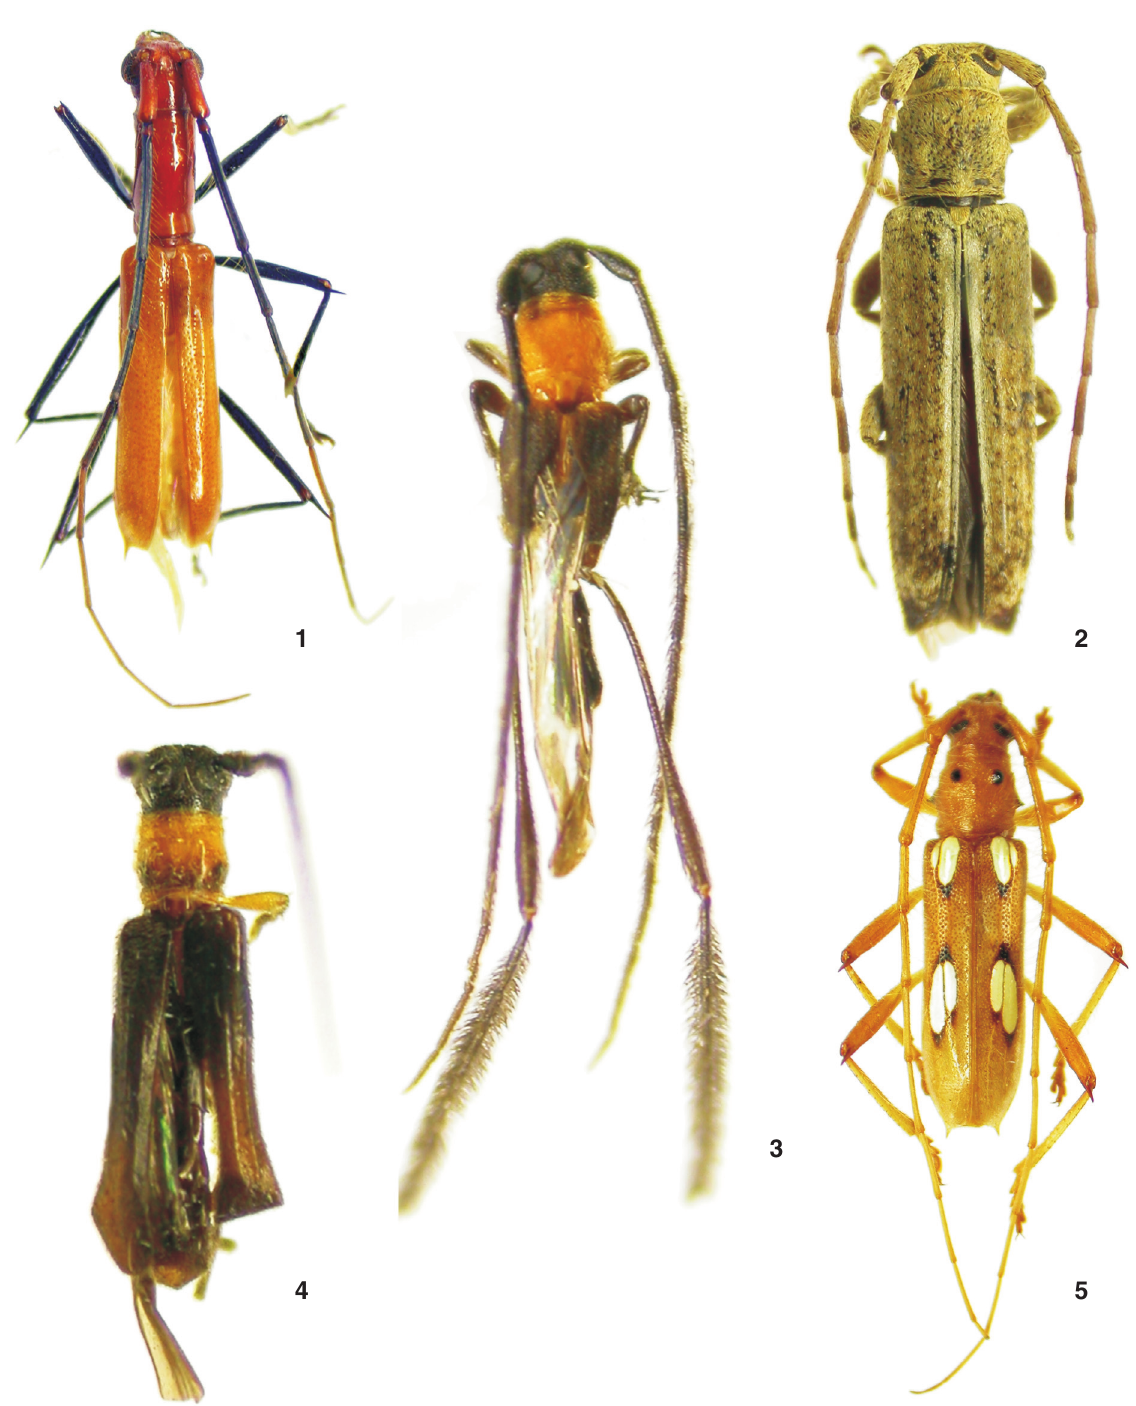
Figuras 1-5. (1) Hexoplon immaculatum sp. nov. , holótipo macho, comprimento 13,8 mm; (2) Bisaltes (B.) petilus sp. nov. , holótipo fêmea, comprimento 11,2 mm; (3) Coleomethia bezarki sp. nov. , holótipo macho, comprimento dos tubérculos anteníferos a ponta dos élitros 3,3 mm; (4) Tessaropa elongata sp. nov. , holótipo fêmea, comprimento 6,5 mm; (5) Eburodacrys inaequalis sp. nov. , holótipo macho, comprimento 13,4